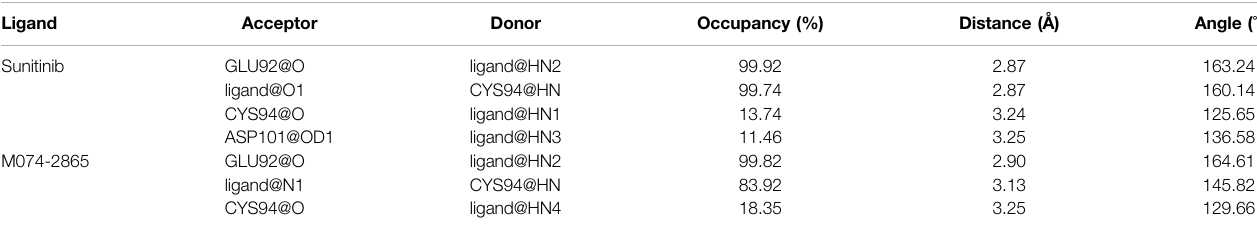
TABLE 2 | Analysis of hydrogen bond interaction between HPK1 and the two inhibitors (sunitinib and compound M074-2865). Ligand Acceptor